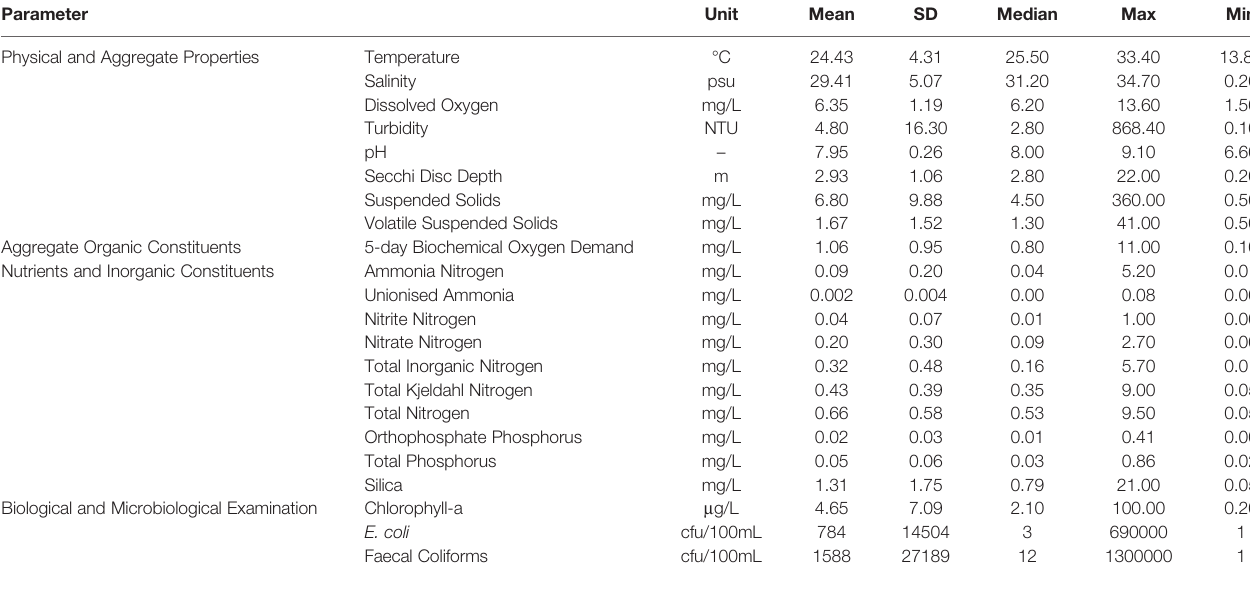
TABLE 1 | Summary statistics of station-based monitoring data of the water quality parameters extracted in this study. Parameter